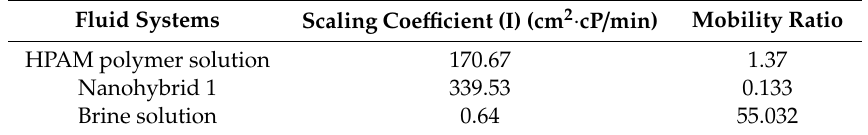
Table 4. Stability criterion results for brine, HPAM polymer solution, and nanohybrid 1